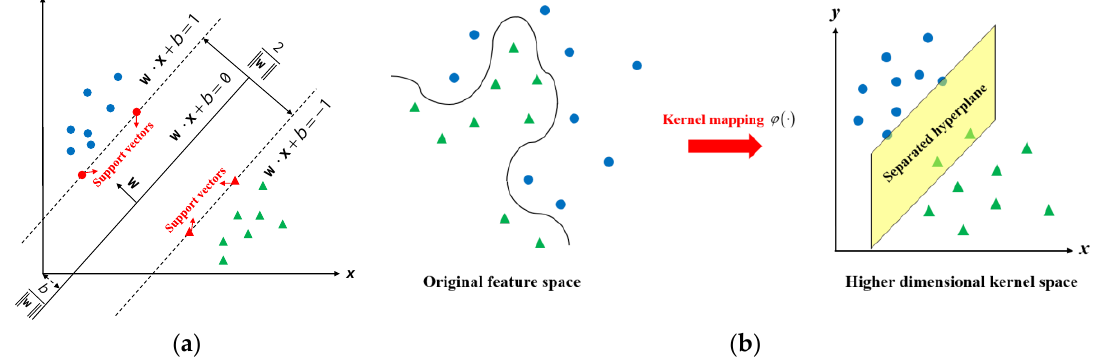
Figure 3. The working mechanism of support vector machine (SVM): ( a ) the linear model; ( b ) the non-linear model.